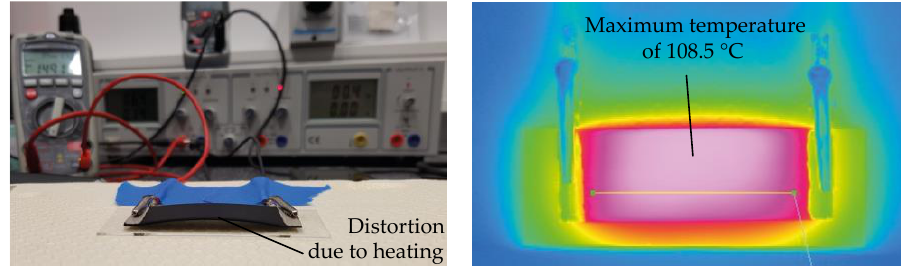
Figure 16. Distortion of the specimen caused by exceeding the glass transition temperature of the matrix polymer and the temperature gradient ( left ); and heat distribution at 12 V ( right ).